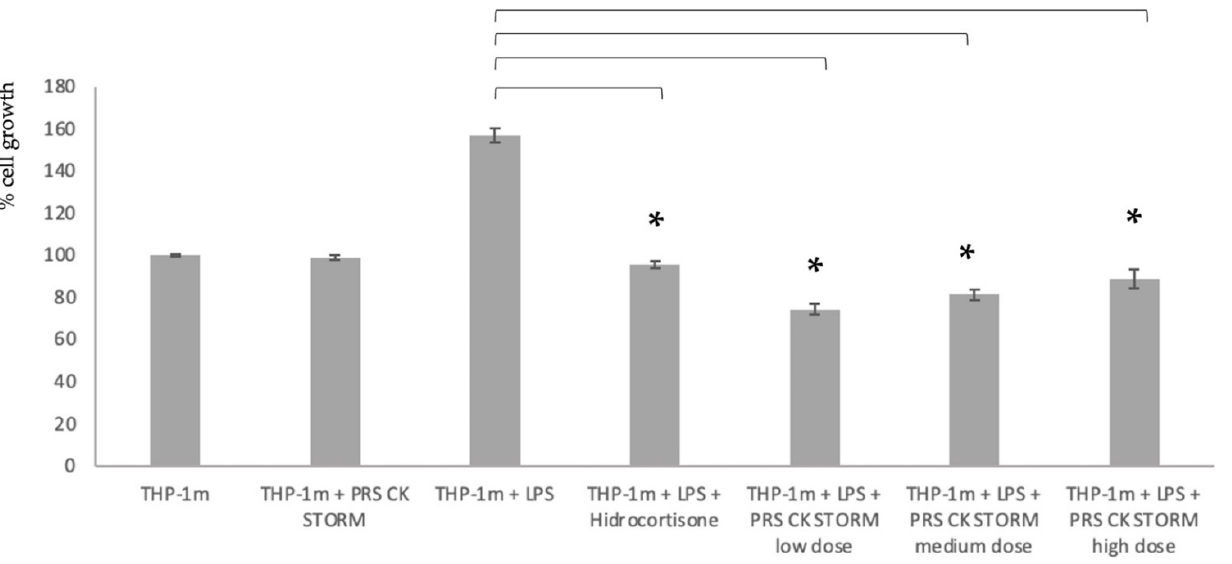
Figure 2. MTT assay with macrophages derived from the THP-1(THP-1m) line, and these were analyzed in three independent experiments with two replicates of the analytical technique. Error bars indicate the standard deviation between samples. Asterisks represent a p -value < 0.05.